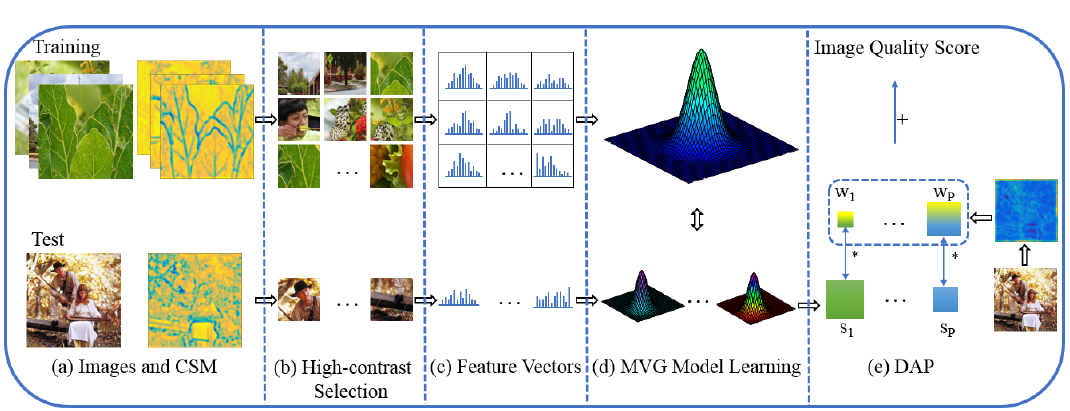
Figure 1. The flowchart of the proposed method for BIQA. It is composed of ( a ) images and CSM, ( b ) selecting high-contrast patches, ( c ) building feature vectors, ( d ) learning MVG models, and ( e ) DAP is used to obtain the overall image quality